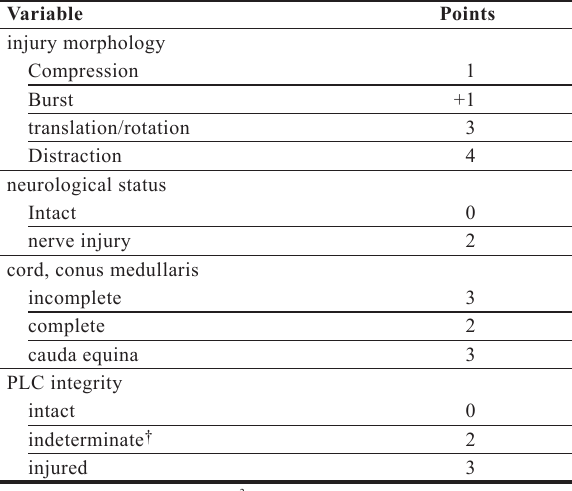
* As reported by Vaccaro et al 3 † For patients with suggested ligamentous injury on STIR imaging or T2-weighted